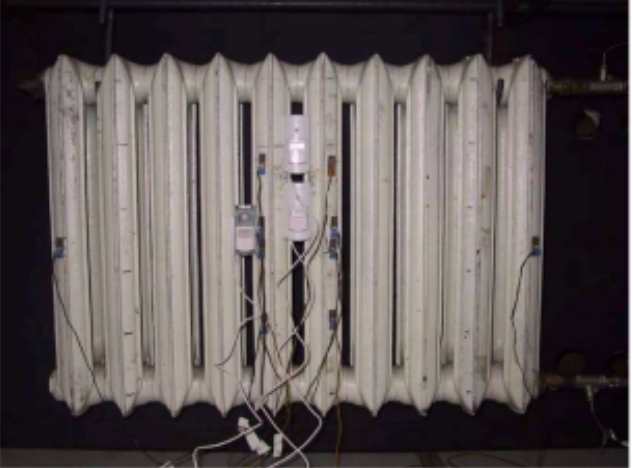
Figure 4. Location of the heat cost allocators and radiator T1 temperature measuring